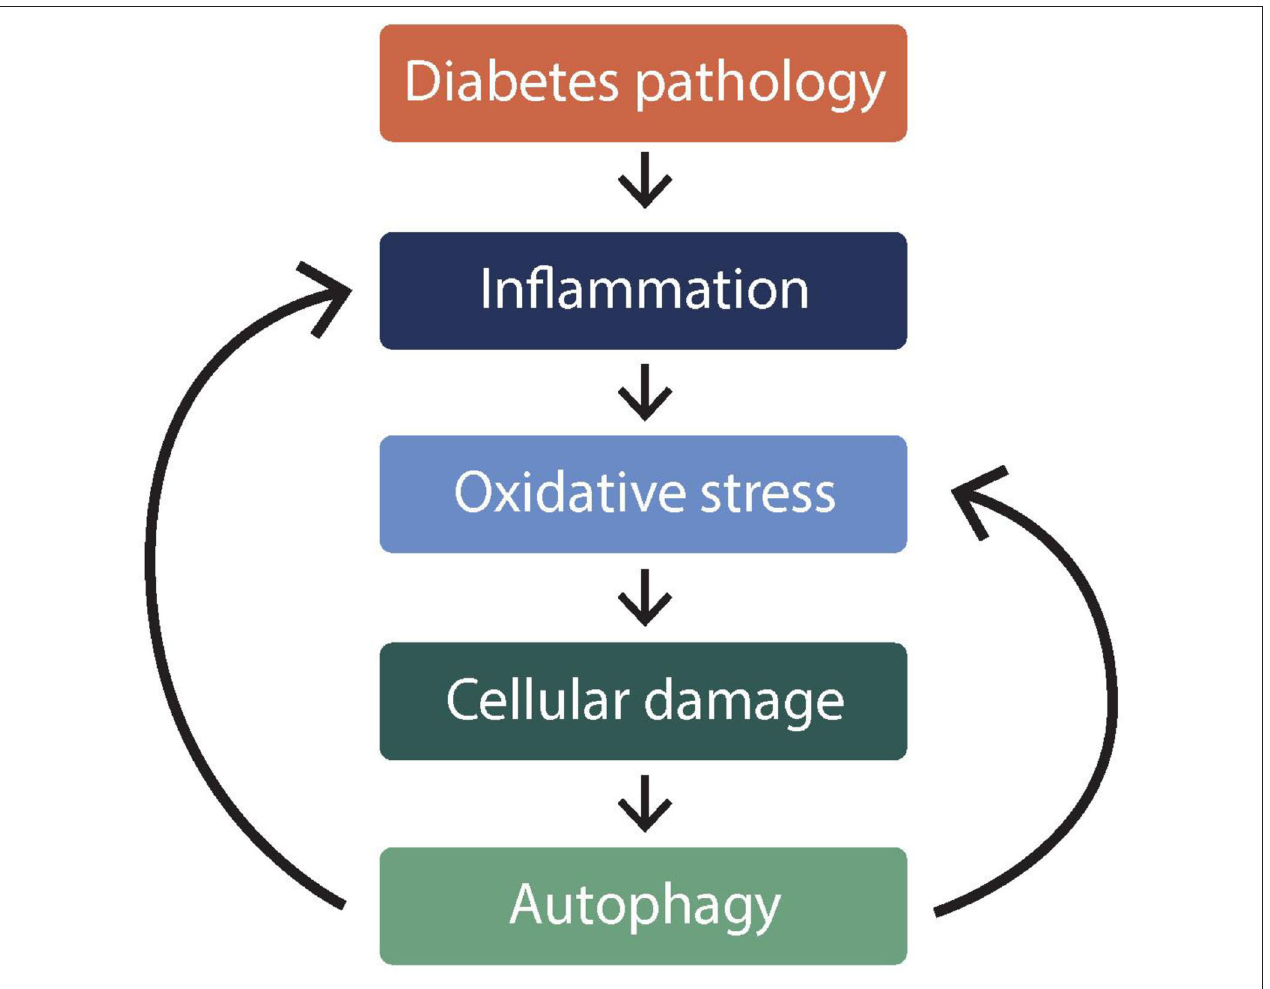
FIGURE 1 | Illustration* of relationship between autophagy and oxidative stress in diabetes mellitus. *This figure illustrates how autophagy is inseparable from inflammation and oxidative stress phenomena. Figure shows that autophagy is caused by (downward arrows), but it also exacerbates (backward arrows), inflammation, and oxidative stress in